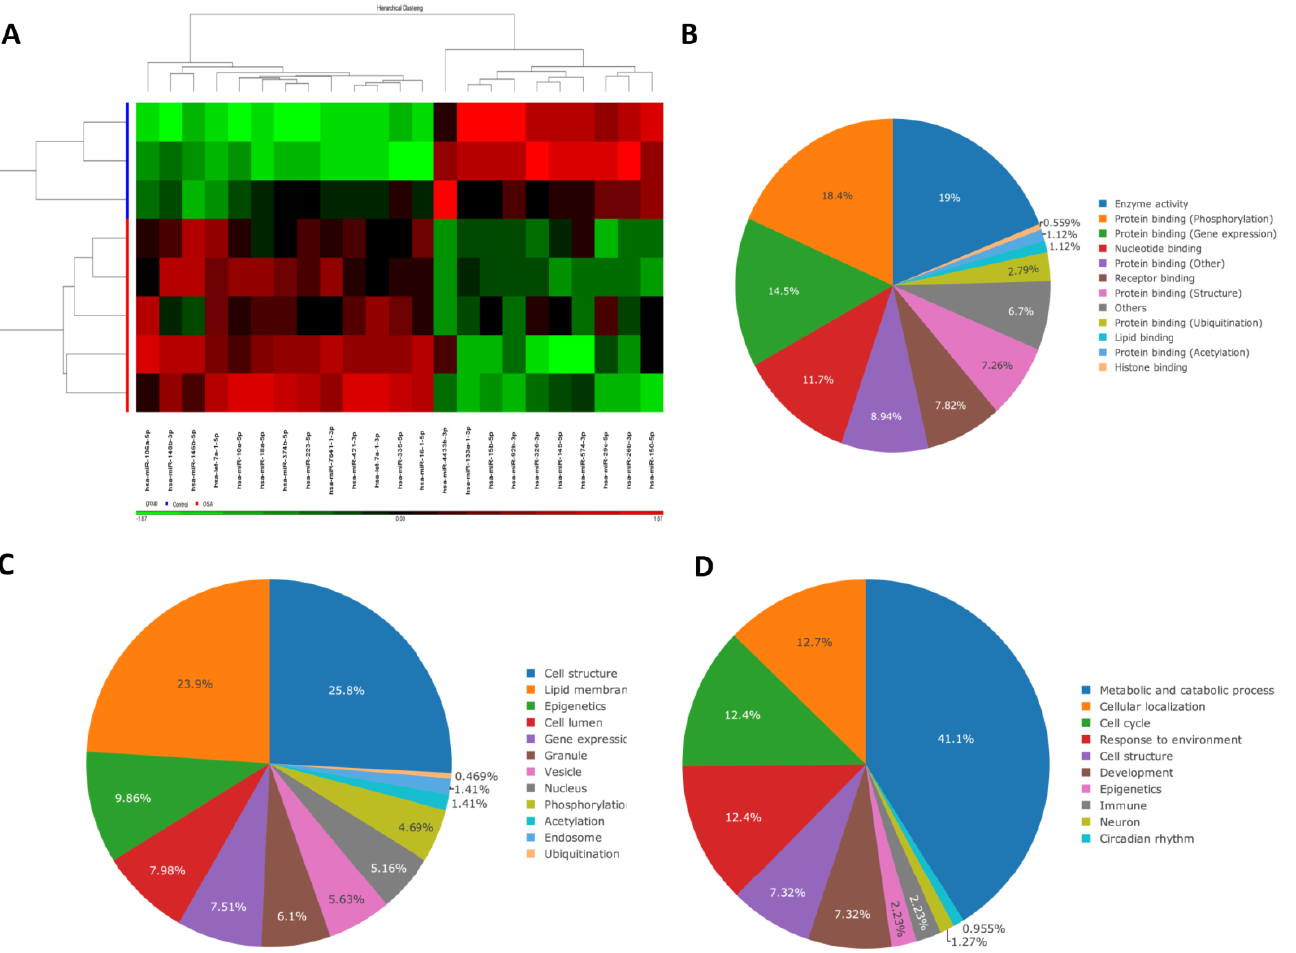
Figure 1. Peripheral blood mononuclear cell (PBMC)-derived microRNA (miRNA) profiling and Gene Ontology (GO) analysis. ( A ) Heatmap illustrating miRNA expression profiling between 16 OSA patients and eight healthy non-snorers (red: increased miRNA expression; green: reduced miRNA expression). GO analysis was used to assess ( B ) molecular functions, ( C ) cellular components, and ( D ) biological processes. The classification shows the top-ranked significant GO terms.